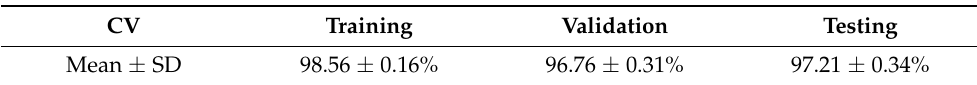
Table 8. First stage Sens, Sp, and F1-score for the 5-fold cross-validation. Noise Table 7. First stage performance measure for the cross-validation (5-fold) using training validation and testing accuracies.